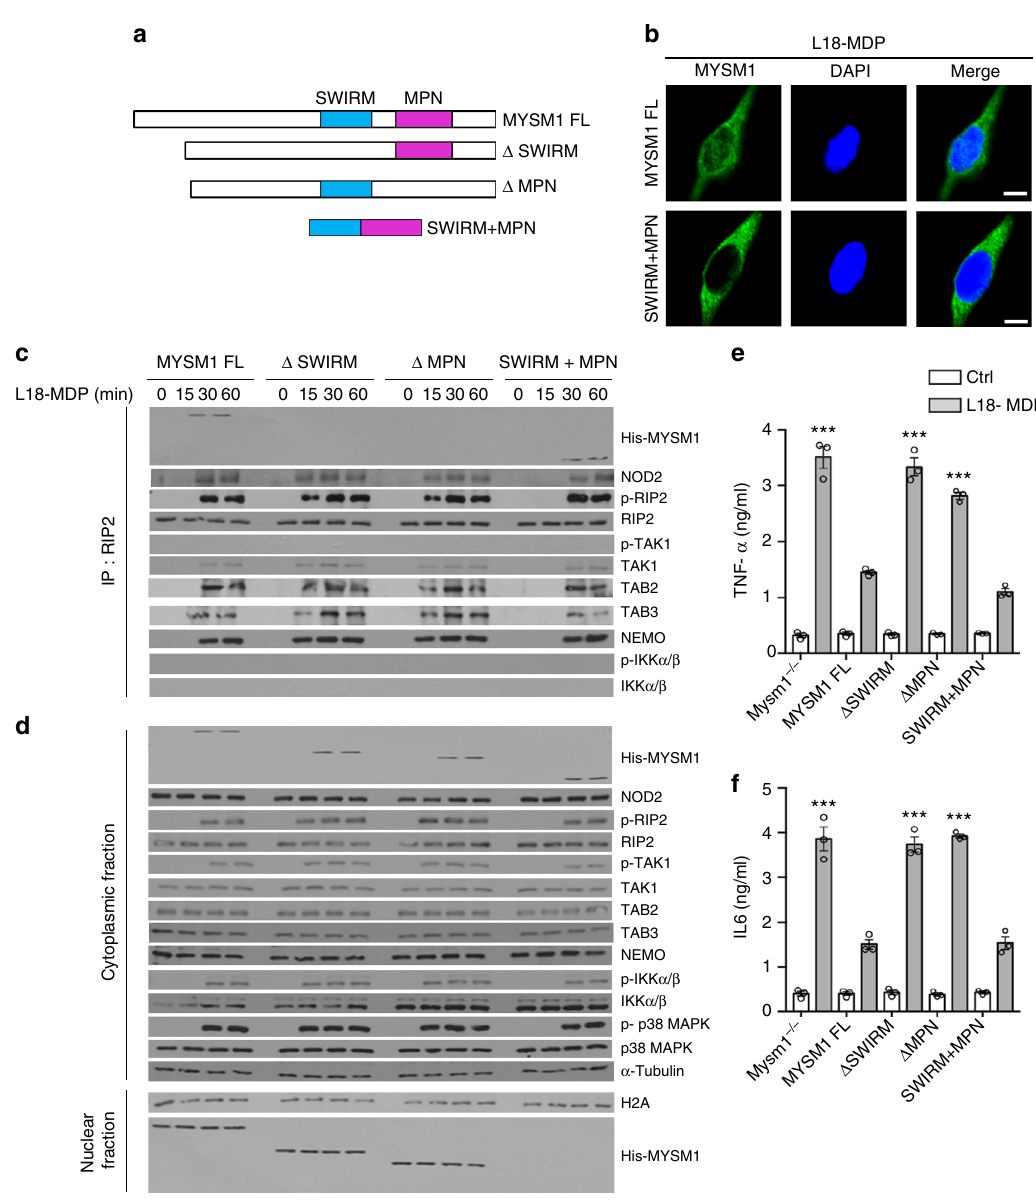
Fig. 6 MYSM1 inactivates RIP2 complex via the SWIRM and MPN domains. a Schematic representation of MYSM1 domain mutant constructs. b Immuno fl uorescence staining of full-length MYSM1 (MYSM1 FL) or SWIRM + MPN in complemented Mysm1 − / − BMDMs 1 h post L18-MDP stimulation. Scale bar (10 µ m). c , d Mysm1 − / − BMDMs complemented with indicated MYSM1 constructs were stimulated with L18-MDP. Cytoplasmic fractions were immunoprecipitated with anti-RIP2. Pulldowns ( c ) and the corresponding cytoplasmic or nuclear fractions ( d ) were analysed for indicated molecules. e – f Mysm1 − / − BMDMs or Mysm1 − / − BMDMs complemented with indicated constructs were stimulated with L18-MDP for 12 h and analysed for TNF- α and IL-6 secretion by ELISA. Results in e – f are from three independent experiments. Data are shown as mean ± s.e.m. ( n = 3). *** p < 0.001 determined